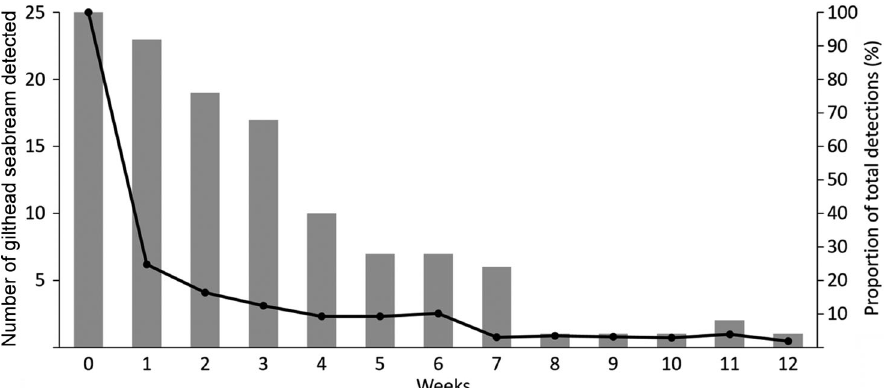
Fig. 2. Number of released Sparus aurata tagged with acoustic transmitters (N = 25) detected in close proximity to release farm over the total study period. Plotted line shows proportion of total fish detections per week at release farm. Week 0 represents date of release of fish from the farm